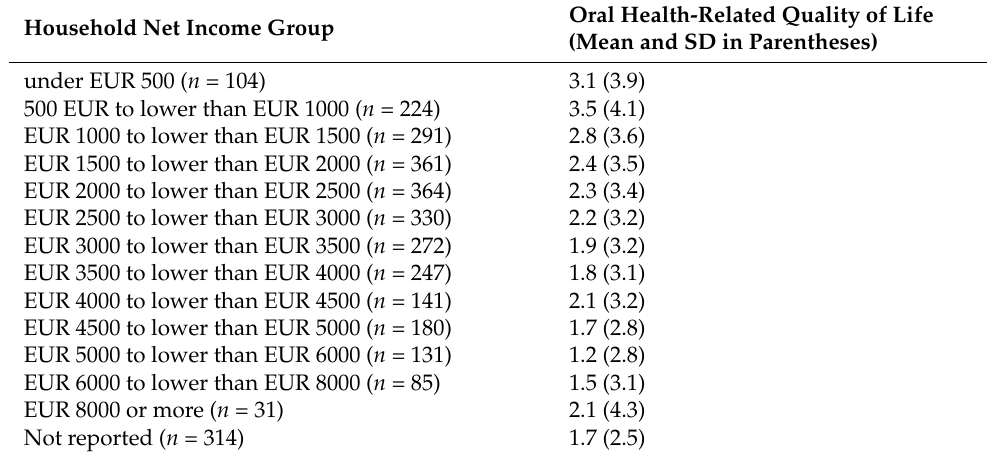
Table 2. Average oral health-related quality of life (stratified by household net income group).